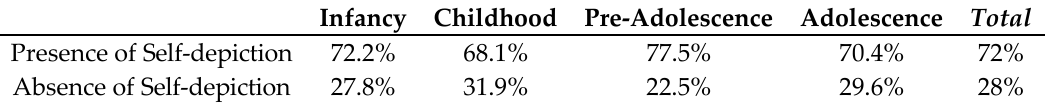
Table 2. Marker “Self-depiction in the drawing”: percentages on the total number of the drawings (286).